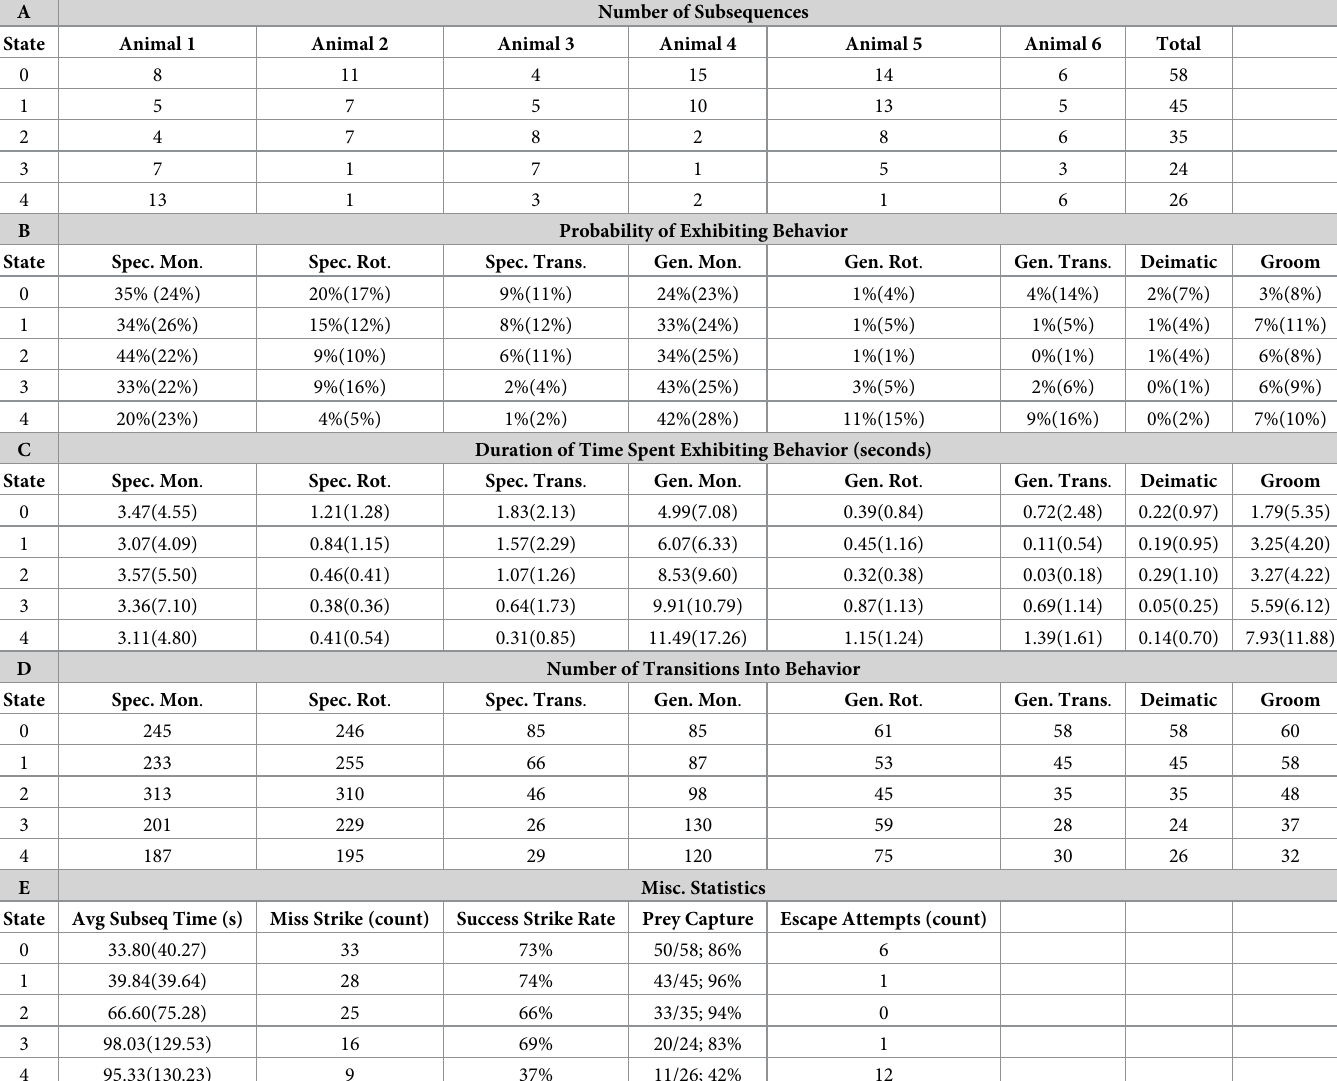
Table 1. Summary of statistics and counts. For each animal, a single video captures behavior while the animal is in a single feed state (5 total videos per animal across the 5 feed states). Each video has a variable number of subsequences depending on the number of arena resets that occurred within that video. (A) Summary of the number of subsequences seen for each animal in each feed state. (B) Summary of behavior probabilities presented in section 3.2.1. (C) Summary of bout times for each behavior pre- sented in 3.2.2. (D) Summary of transition count into each behavior by feed state. (E) Summary of miscellaneous metrics that include the average length of subsequences for each feed states, miss strike count, successful strike rate (number of successful prey captures divided by total number of prey capture attempts), number of sequences that end with prey capture, and number of escape attempts by feed state. C and E are reported as μ